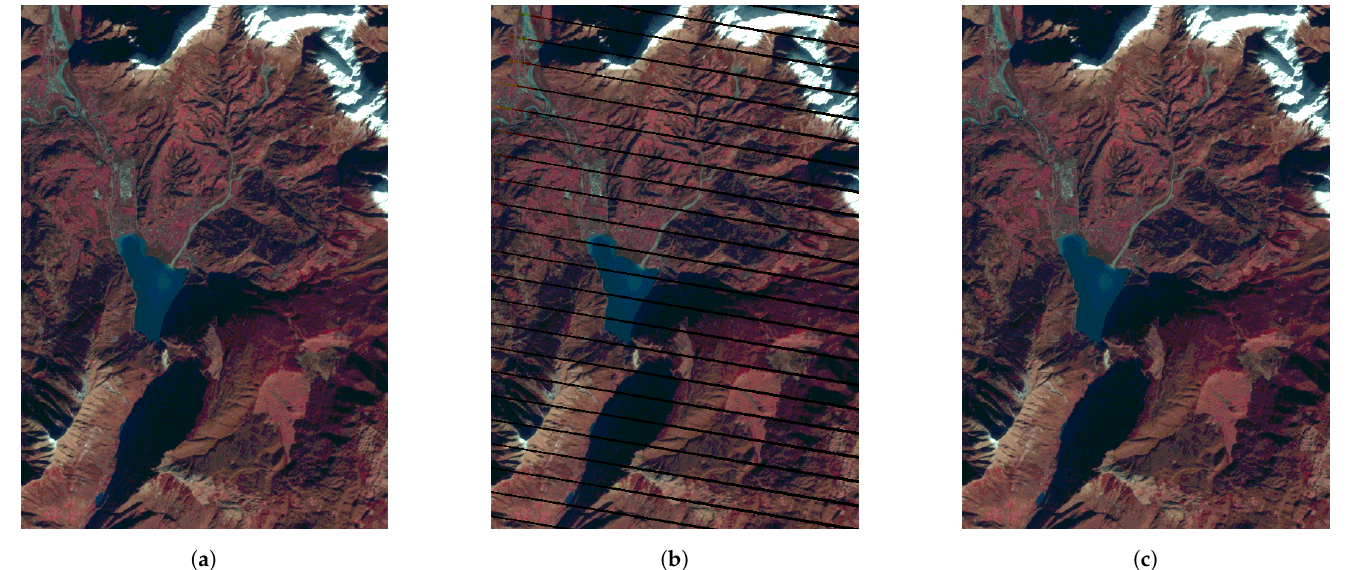
Figure 13. Base, target, HM reconstruction of the NRG band set of Landsat 7 LE71920282000332NSG00 scene. ( a ) base image; ( b ) target image; ( c ) HM reconstruction.